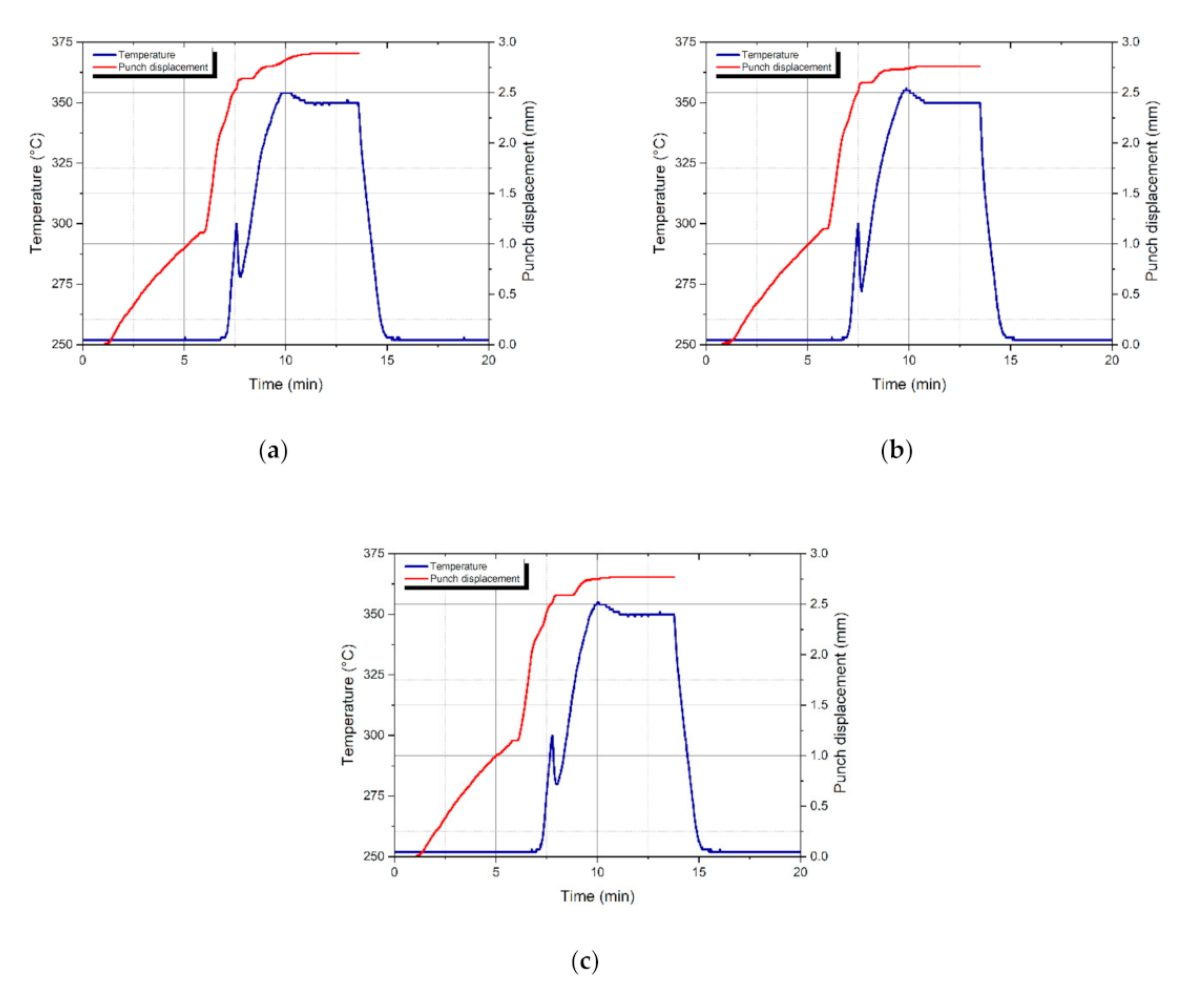
Figure 1. Temperature change and punch displacement recorded during the SPS of powders milled for ( a ) 13, ( b ) 20, and ( c ) 70 h,